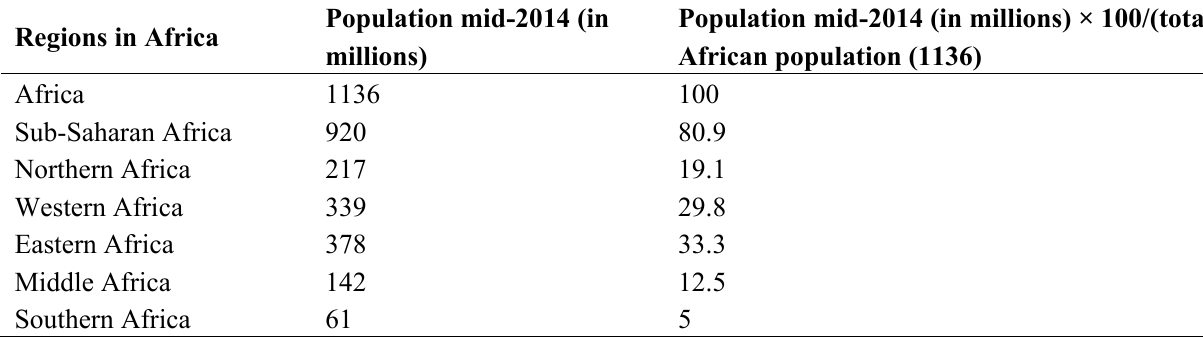
Table 2. Mid-2014 populations (in millions) in